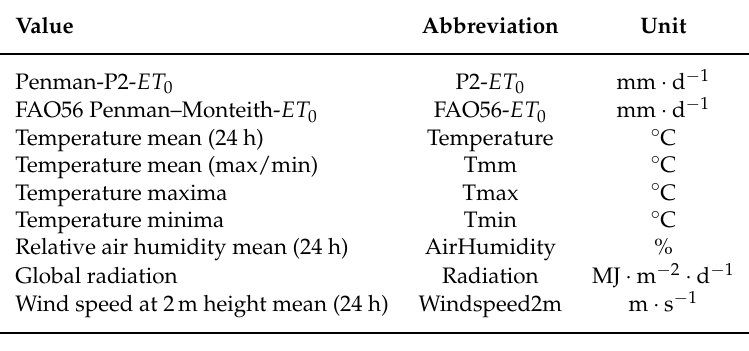
Table 1. Overview of the daily weather data with units and